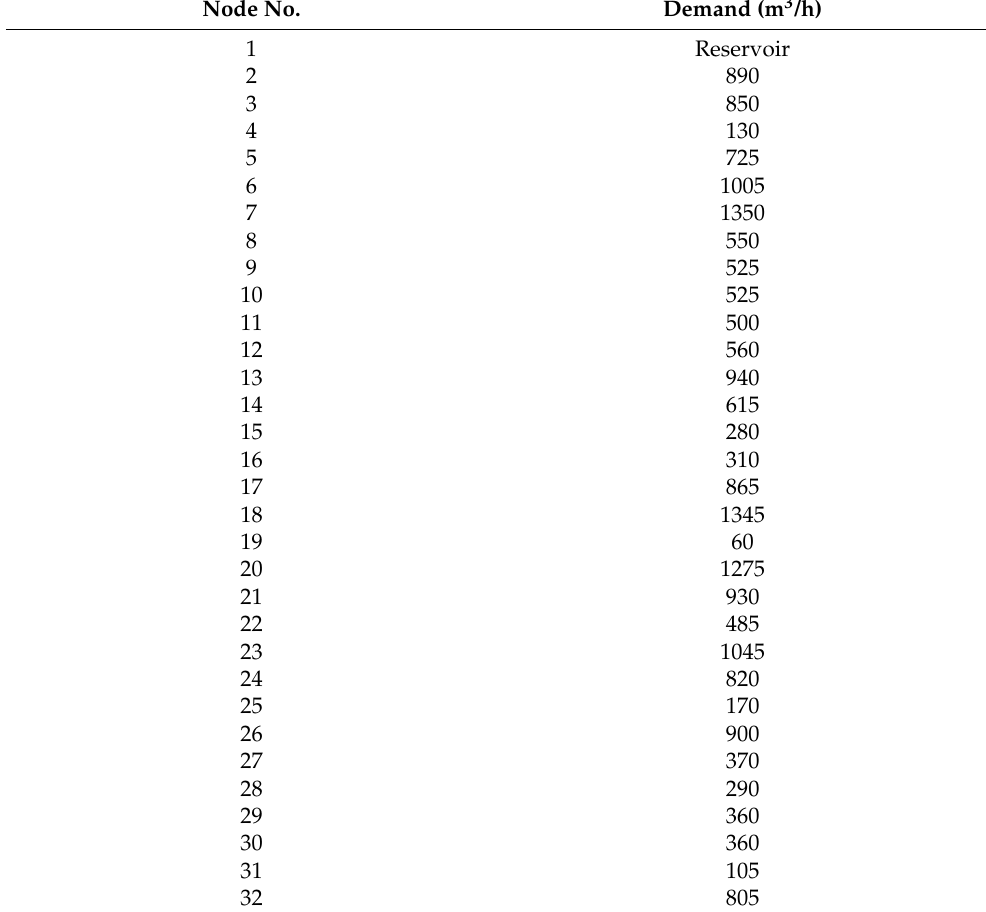
Table A3. Node data for the Hanoi network.